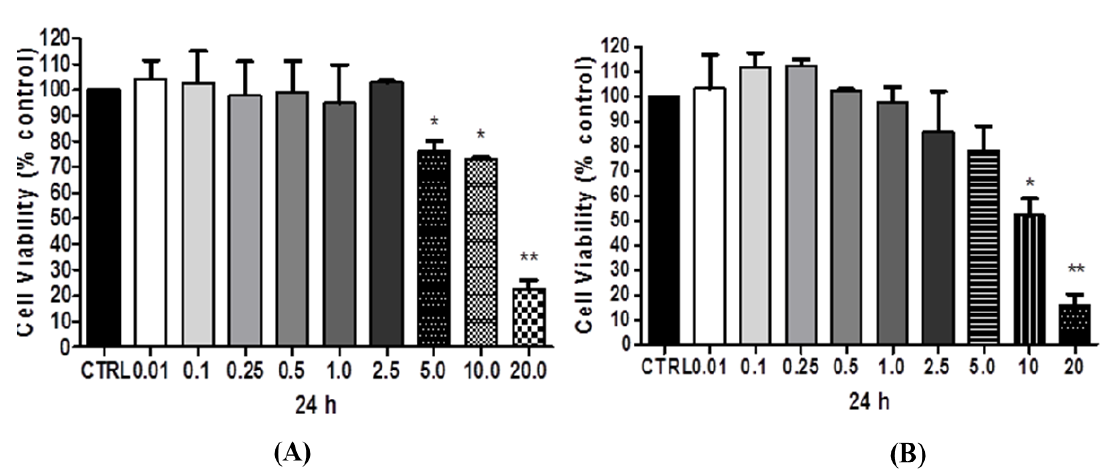
Figure 1. E ff ect of ME and TAP on A2780 cell viability. ME ( A ) and TAP ( B ) were tested for their e ff ect on A2780 cell viability after 24 h of treatment using MTT assays. Significant di ff erences between the untreated cells and those incubated with the respective extracts (0.01–20 mg / mL) were compared by one-way ANOVA, followed by Tukey’s post-test (* p < 0.05; ** p < 0.01). Bar 100 µ